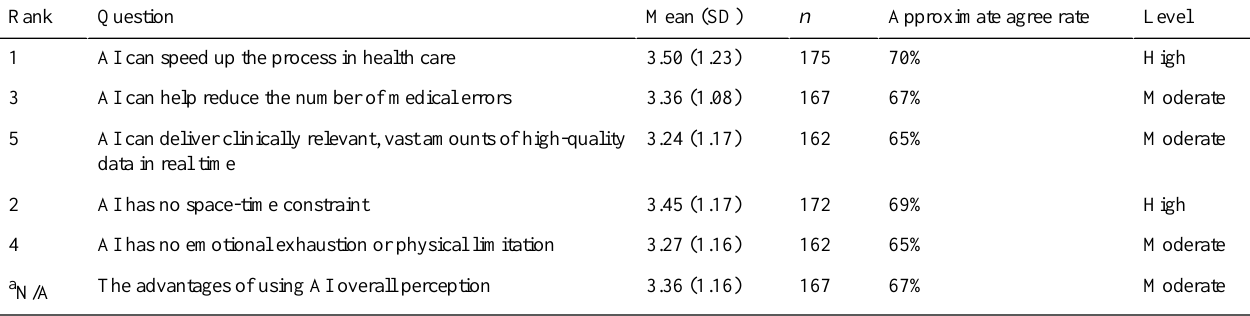
Table 4. The advantages of using AI (N=250).